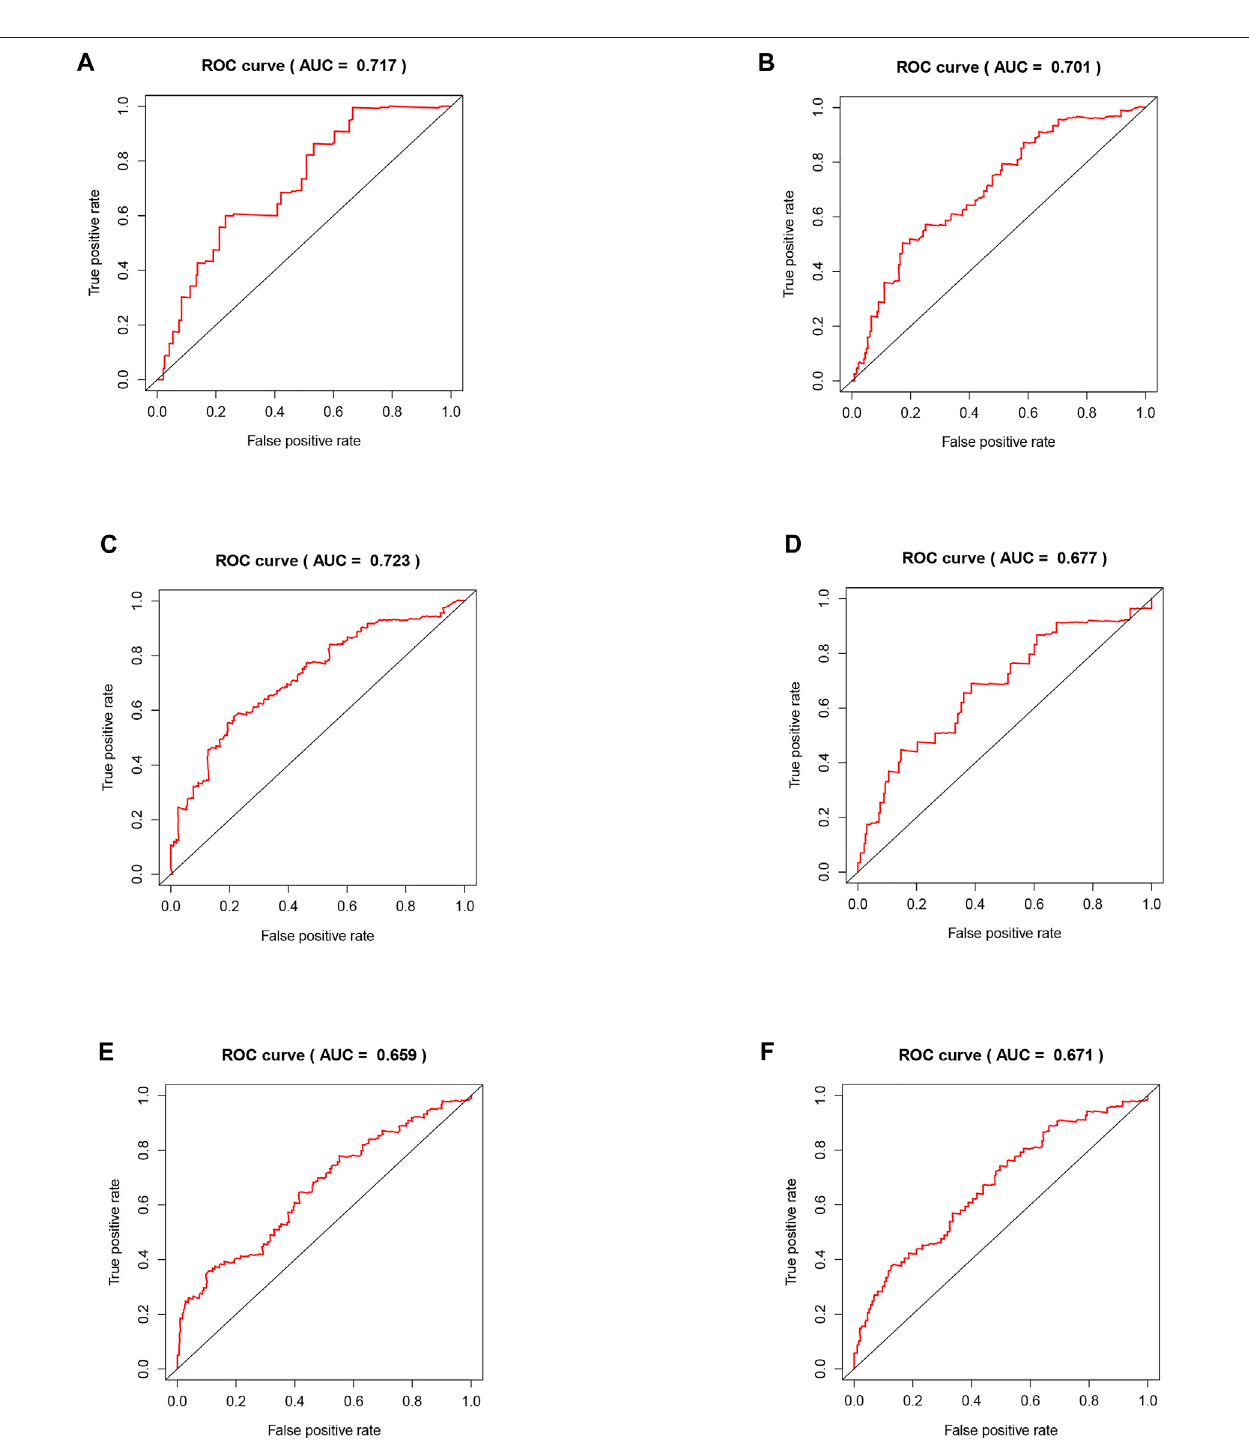
FIGURE 4 | Validation of the risk model related to fi ve regulators. (A – C) The training set of the ROC curve for evaluating the prediction ef fi ciency of the prognostic signature. (D – F) The validation set of the ROC curve for evaluating the prediction ef fi ciency of the prognostic signature.